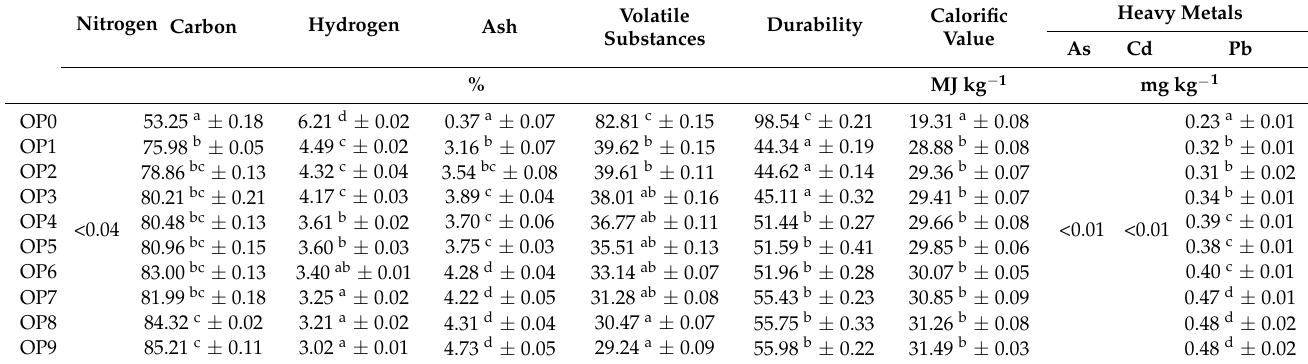
Table 4. The content of general nitrogen, total carbon, hydrogen, ash, volatile substances,